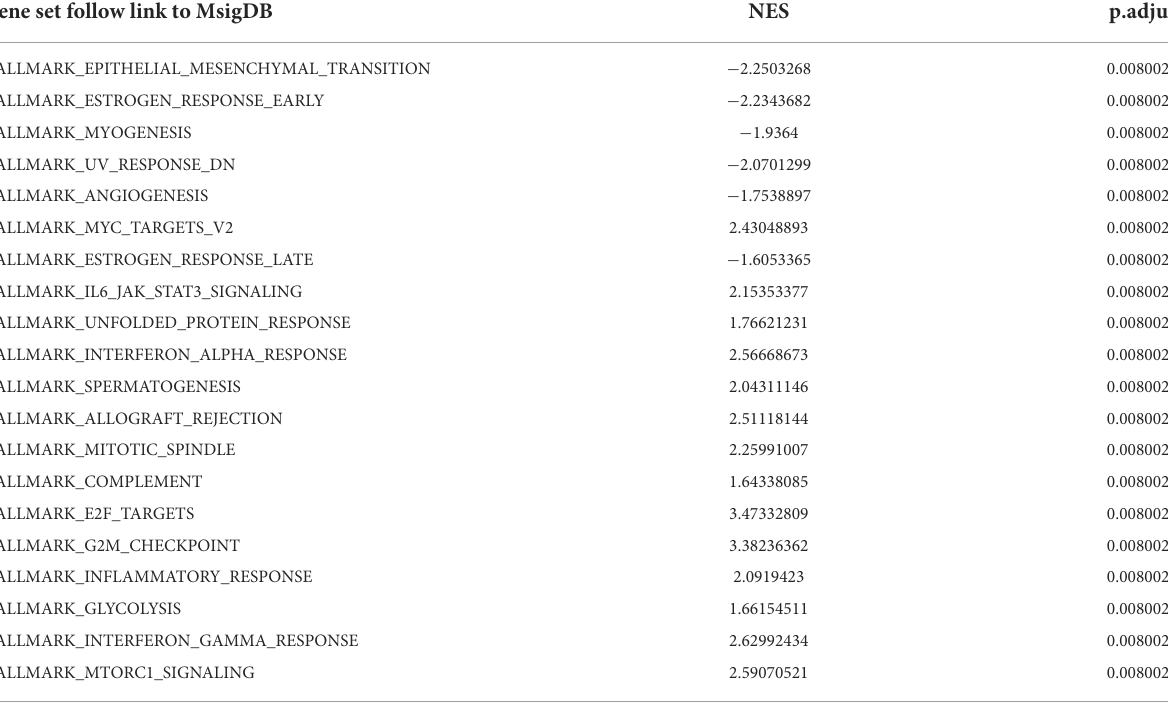
TABLE 2 The top 20 gene sets of before abatacept treatment vs. post abatacept treatment in gene set enrichment analysis. Gene set follow link to MsigDB